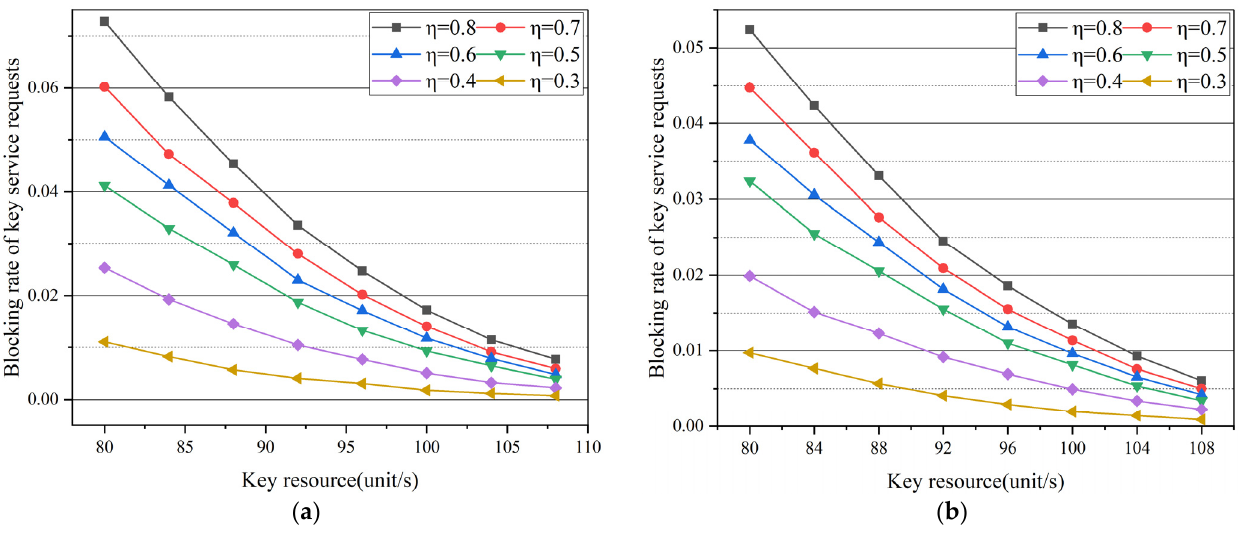
Figure 5. Simulation results: ( a ) blocking rate of key service requests varies with link key resources in the case of different protection thresholds in NSFNET; ( b ) blocking rate of key service requests varies with link key resources in the case of different protection thresholds in USNET.